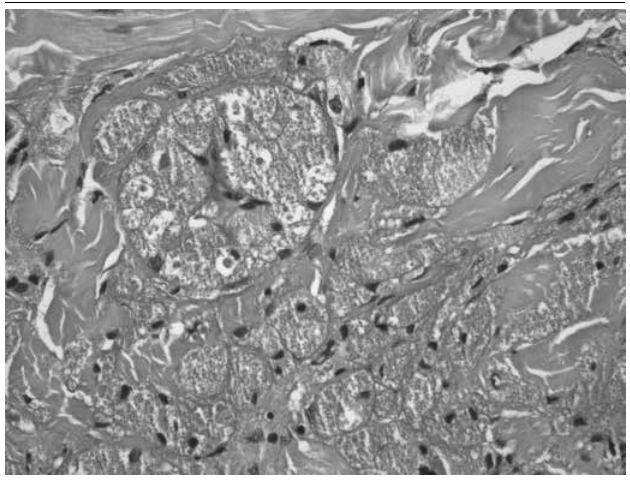
figurE 2 – Histopathological exam of vulvar skin: cells with wide finely eosinophilic granular cytoplasm and oval normochromatic nuclei. Magnification